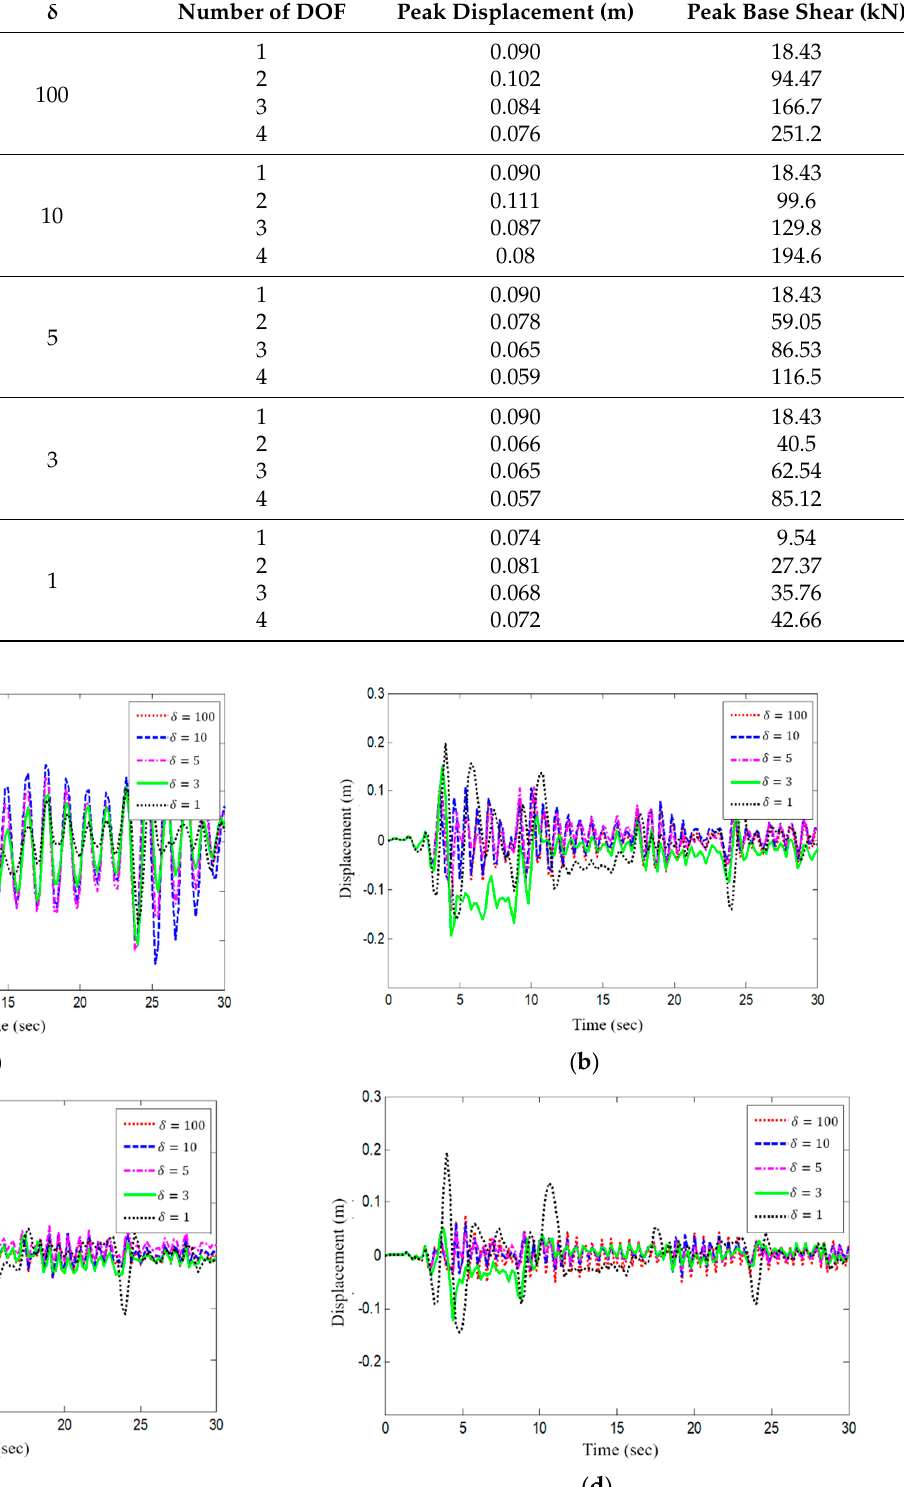
Table 2. Response for varying δ and degrees of freedom.